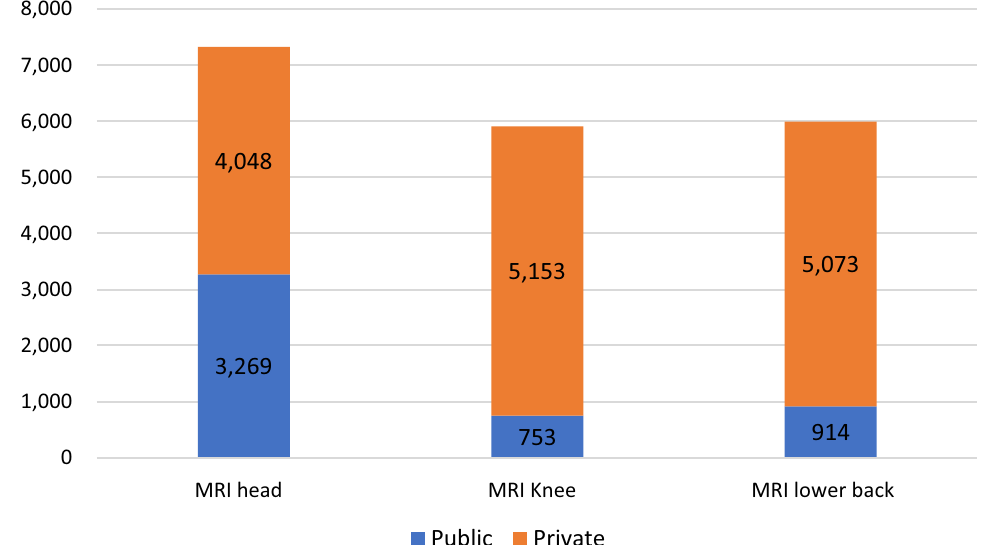
Fig. 3 Imaging distribution between public and private providers. Distribution of examinations related to the CW-recommendations between public and private providers